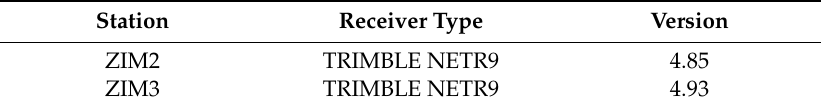
Table 1. Receiver information of ZIM2 and ZIM3 on DOY 150, 2015.